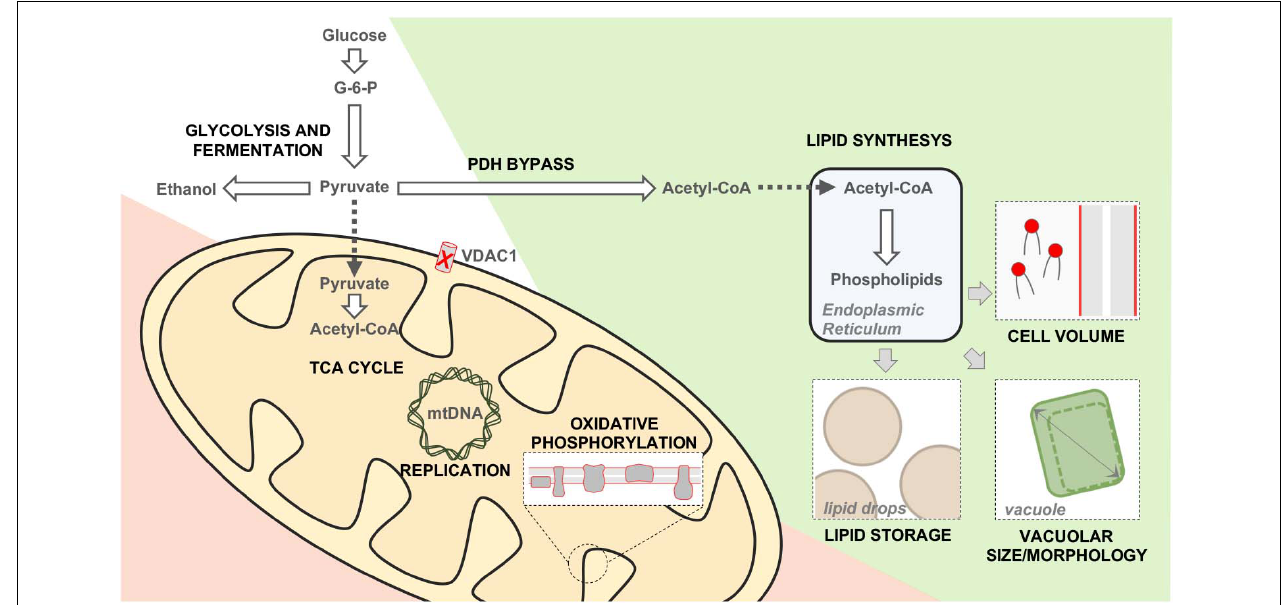
FIGURE 3 | Metabolic and phenotypic changes occurring in (cid:49) por1 cells. Schematic representation of the main changes occurring in yeast upon POR1 gene inactivation. Metabolic down-regulated, upregulated or unchanged pathways are displayed in red, green and white, respectively. The absence of yVDAC1 reduces the nucleotides trafficking within mitochondria, affecting the replication/expression of the mtDNA. The mitochondrial utilization of pyruvate, TCA cycle and the functioning of the electron transport system are strongly compromised. On the other hand, the cytosolic conversion of pyruvate into acetyl-coA is enhanced (PDH by-pass). The latter is addressed toward the synthesis of phospholipids, which are then stored into lipid drops (an energy reservoir). Furthermore, the newly synthetized phospholipids contribute to build plasma membrane and to increase the vacuole dimension. As a consequence, the size of (cid:49) por1 cells is increased of about 30% in comparison to the